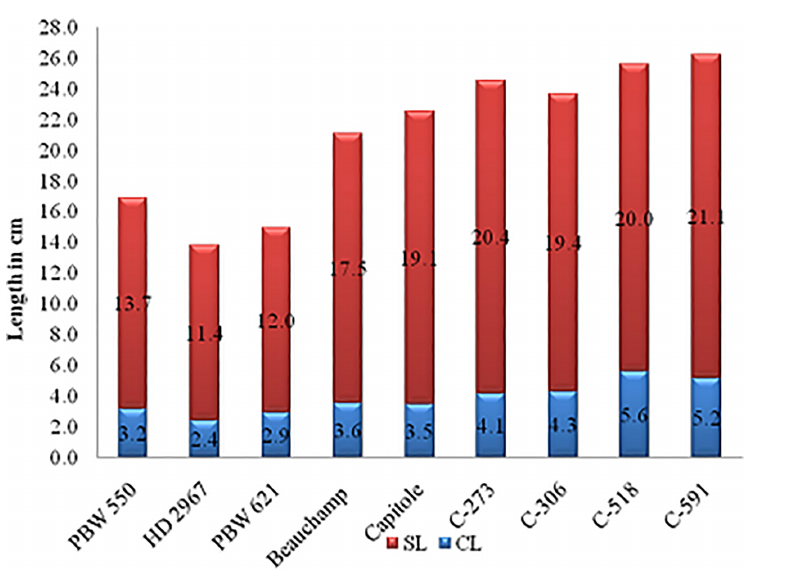
Fig 2. Graphical representation of CL and SL of some